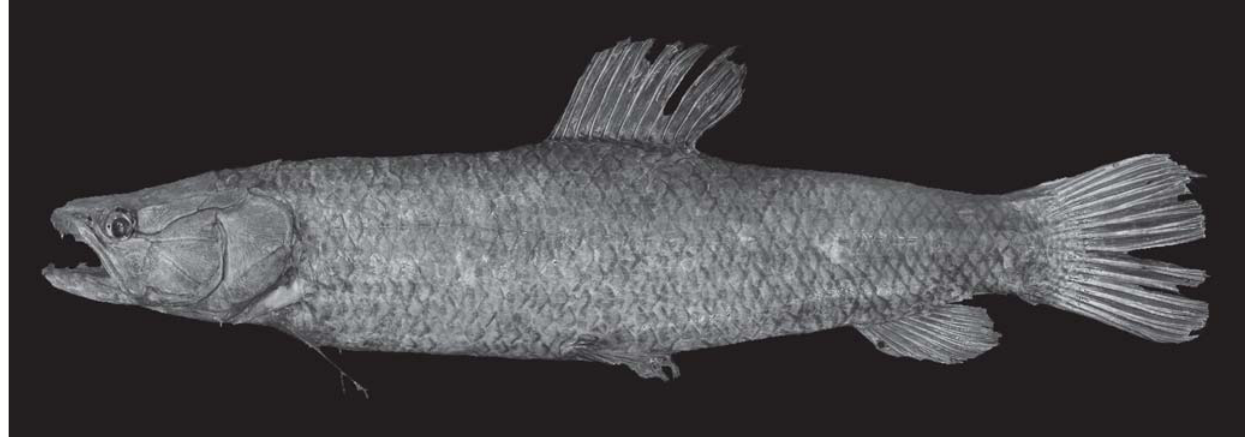
Fig. 9. Hoplias intermedius (lectotype of Macrodon intermedius ) BMNH 1861.5.16.6, 533.4 mm SL, rio Cipó, Minas Gerais State,